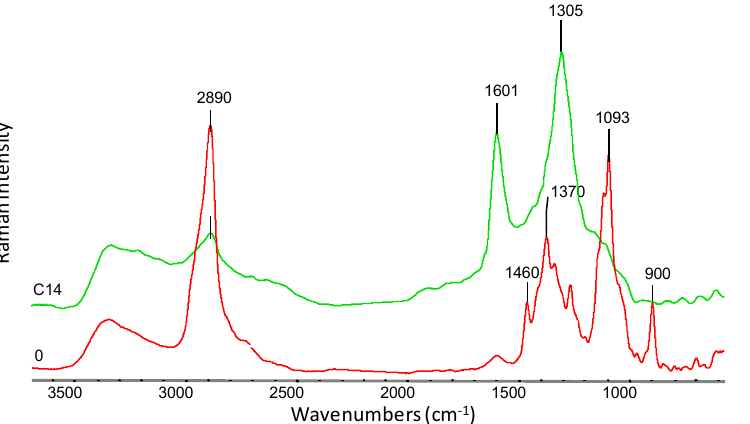
Figure 10. FT-Raman spectra in the range of 3700 - 500 cm − 1 for: 0 - viscose nonwoven, C14 - modified nonwoven C after 14 weeks of study.